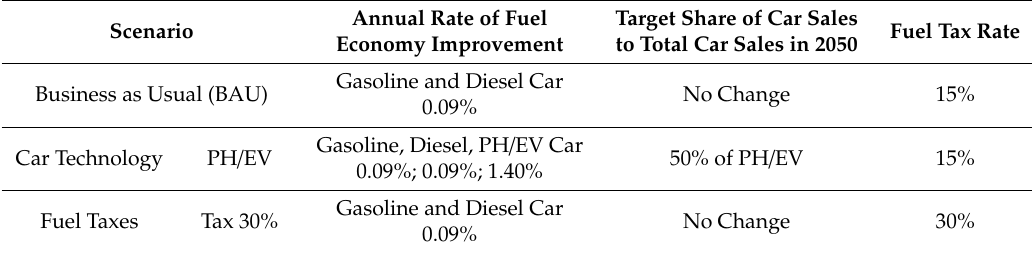
Table 3. Comparison of assumptions among scenarios.